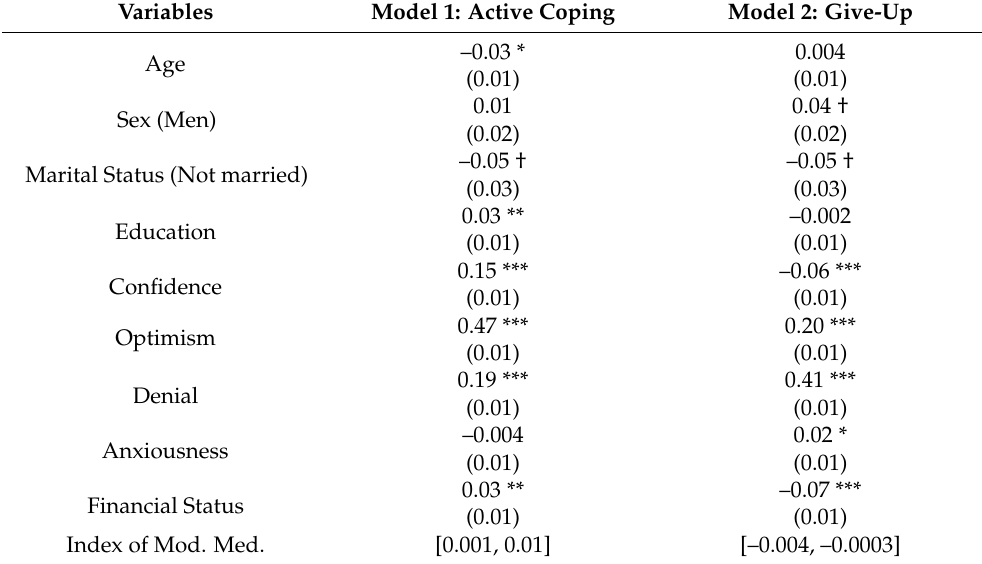
Table 4. Coefficient parameters for variables in moderated mediation models after controlling for covariates.